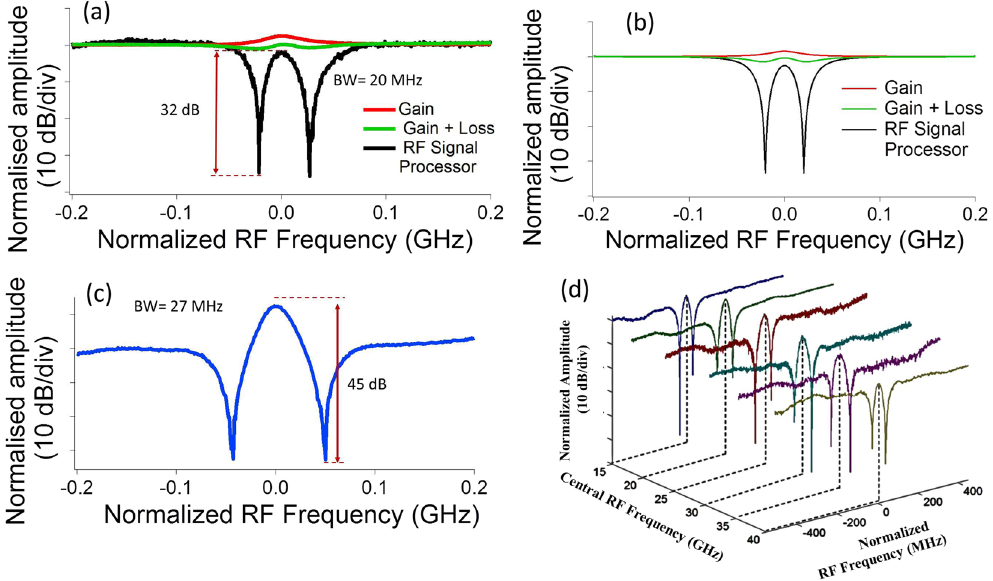
Figure 2. High Resolution filter. ( a ) The SSB response for the gain (red), gain with loss (green) resonance and the RF processor response (black) measured for a signal generator frequency ( β /2) of 20 MHz and a total power of 36 mW, ( b ) the simulated results for same experimental conditions, ( c ) a filter formed using β /2 = 25 MHz, total power of 117 mW, and ( d ) the tuning of the central frequency of the filter. The value of β /2 was kept at 30 MHz and the total pump power was kept constant at 36